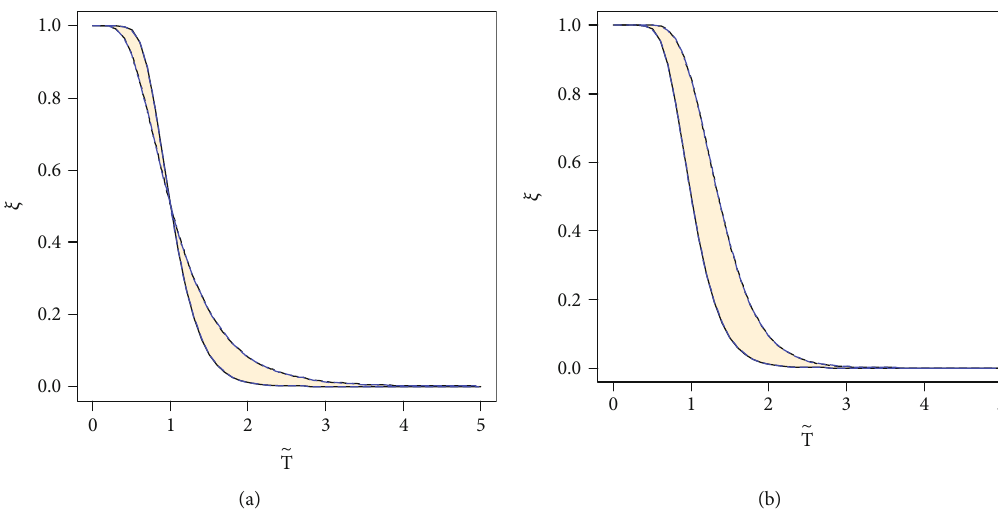
= ½ 0 : 3, 0 : 6 (cid:2) and (b) μ = ½ 0, 0 : 3 (cid:2) n n